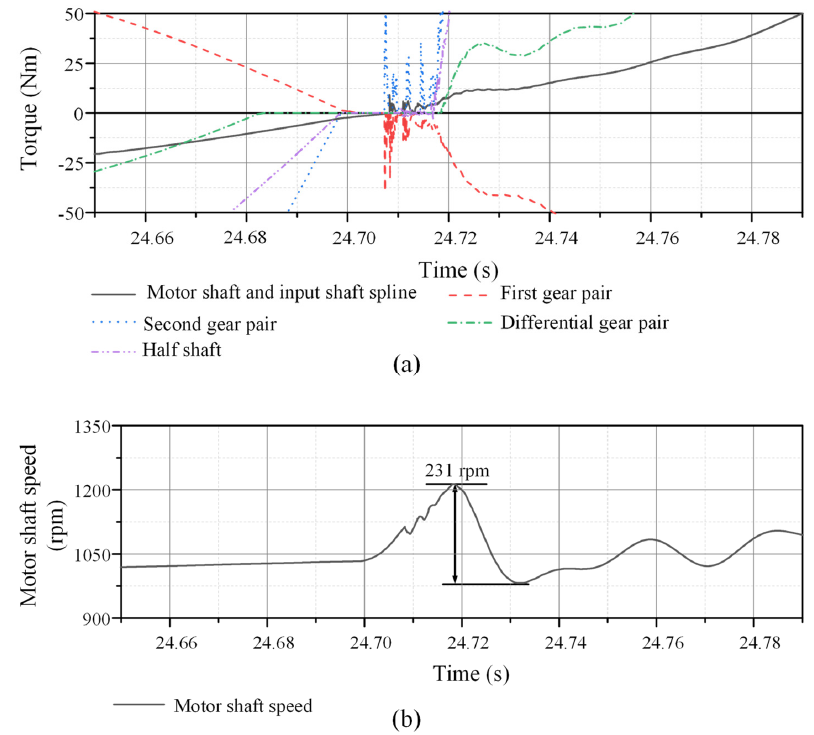
Figure 5. Torques and speed during the pedal tip-in operation.(( a ) Torque curves corresponding to the first and second-level meshing pairs. ( b ) Motor shaft speed). the first and second-level meshing pairs. ( b ) Motor shaft